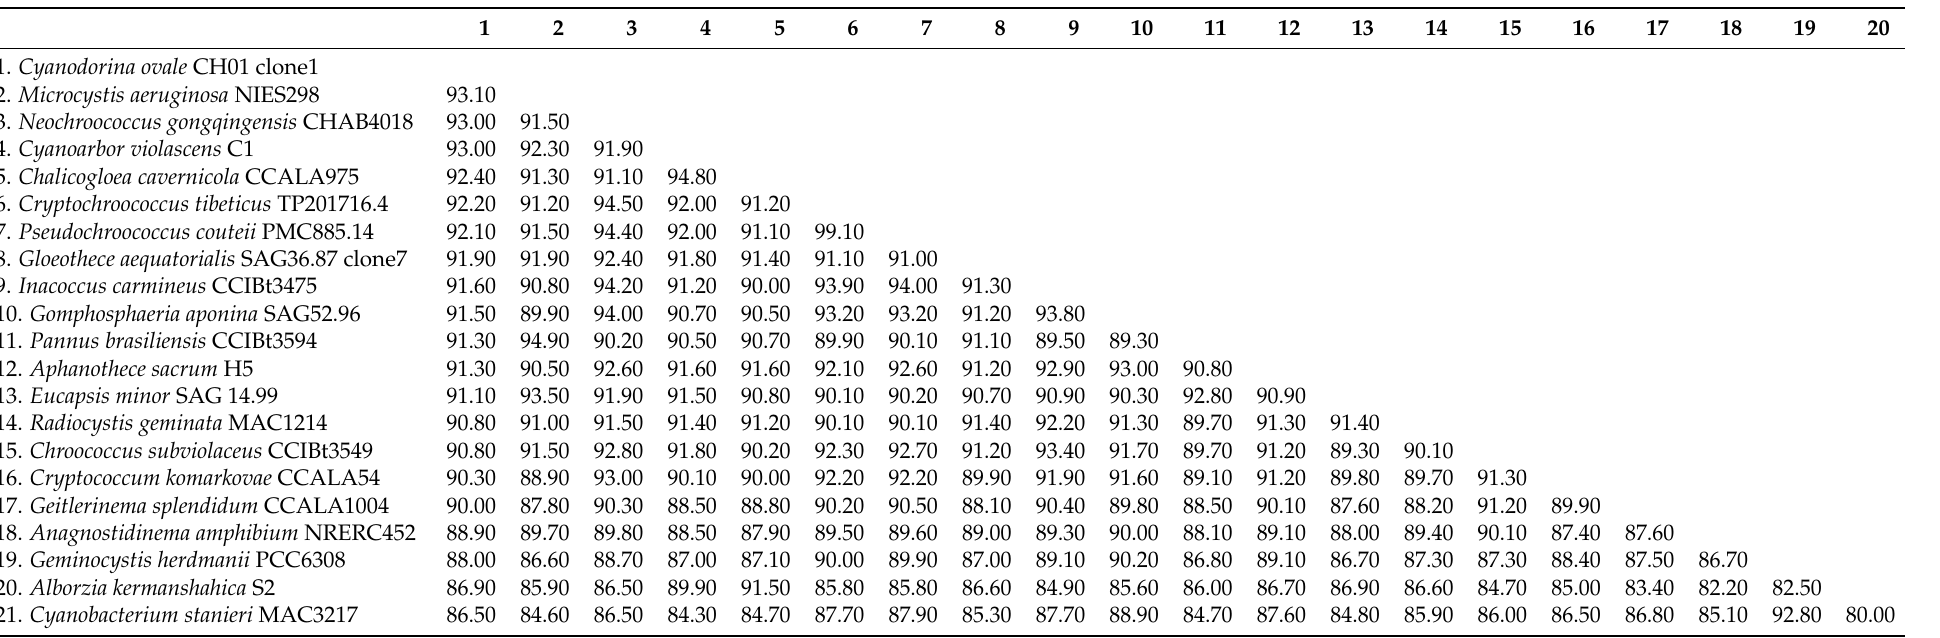
Table 1. Sequence similarity comparison of the 16S rRNA gene between Cyanodorina ovale CH01 and species of close genera.